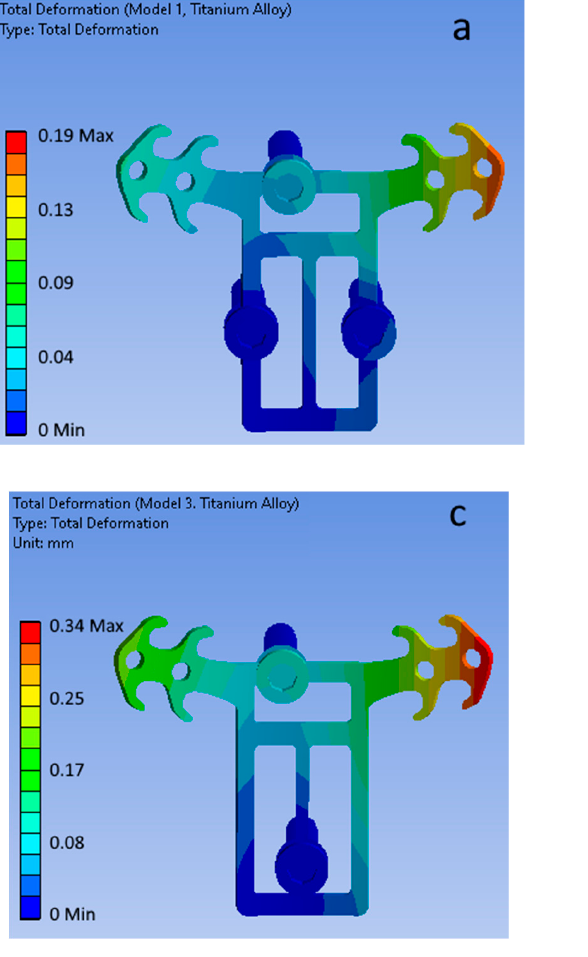
Figure 6. Total displacement fields for ( a – d ) mini-implant configurations (POD material—titanium alloy). ( a ) Model 1. ( b ) Model 2. ( c ) Model 3. ( d ) Model 4.